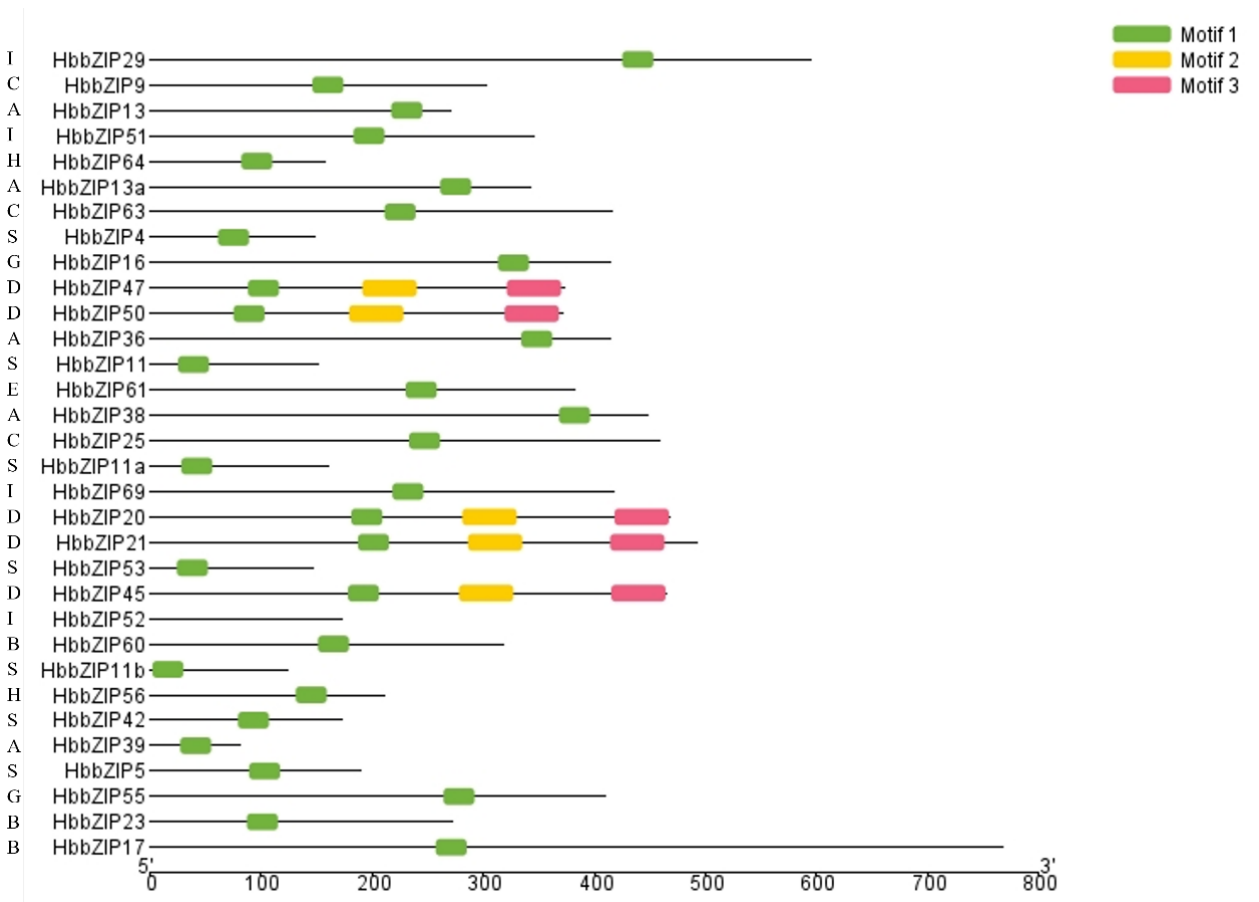
Figure 2. Motif structure of 33 HbbZIPs in rubber trees.